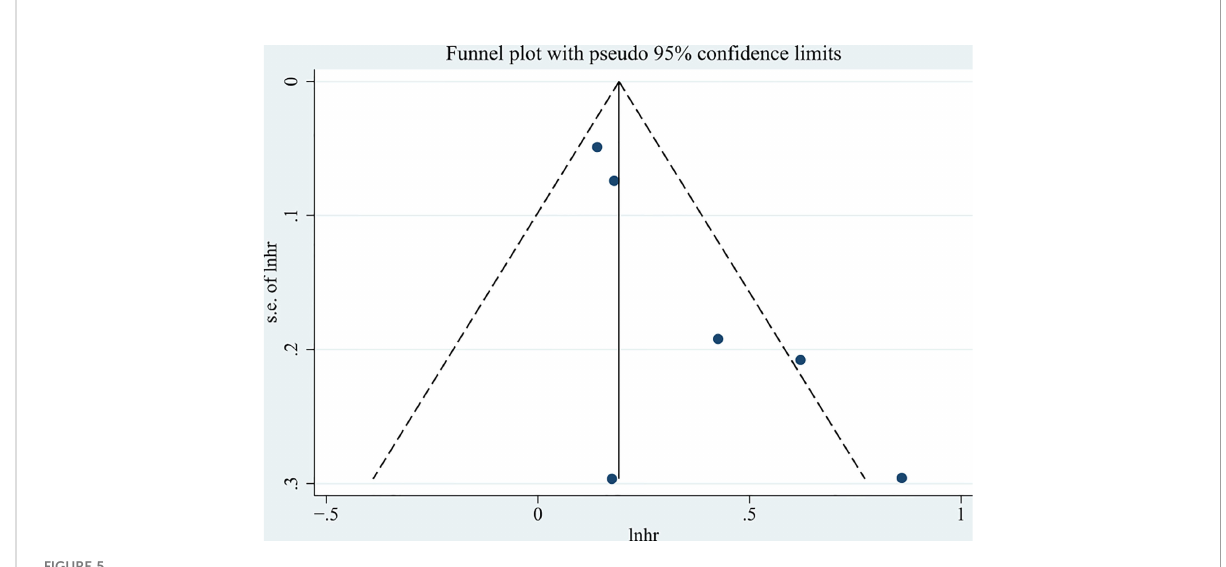
FIGURE 5 The funnel plot of the six selected